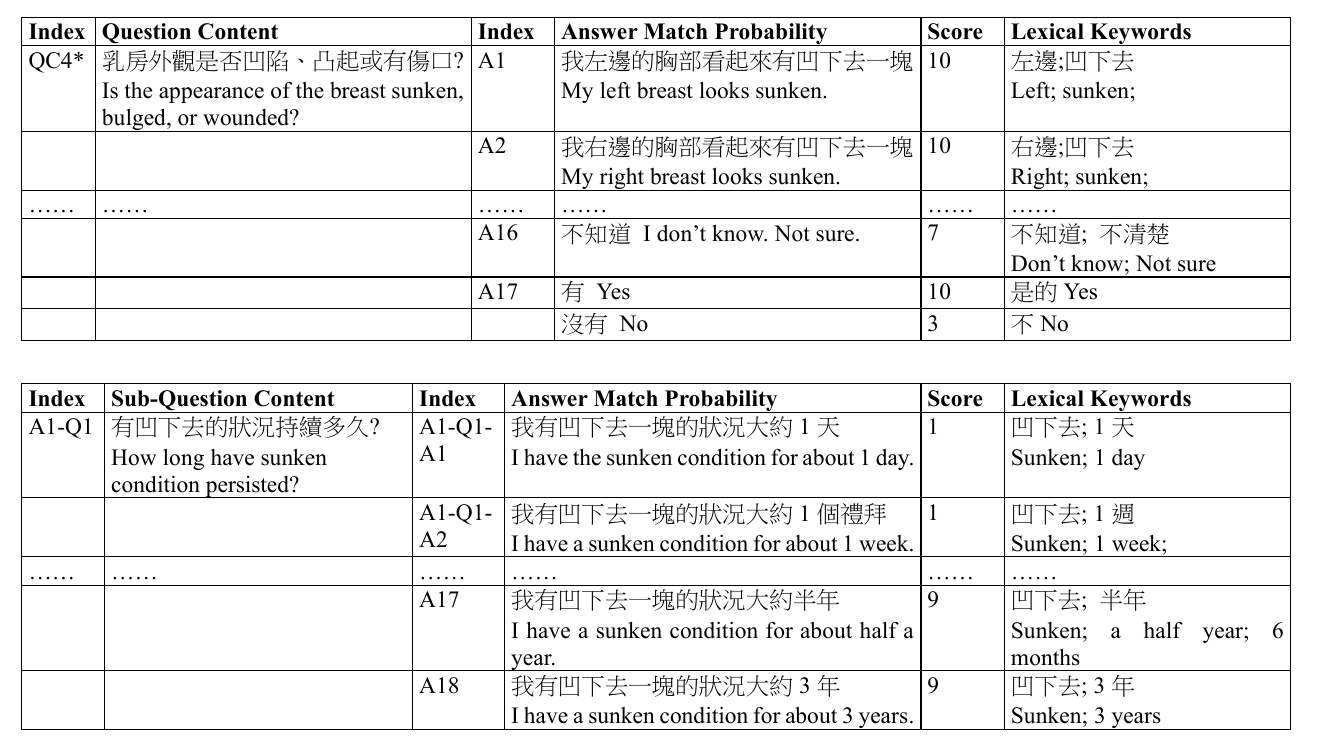
Figure 4. Sample of the Q&A assessment knowledge-base data structure indicating how the context of a user’s response to a main question category (e.g., QC4) query is matched and scored by the SAC, which also proceeds to query the user further with a sub-question regarding the symptom.